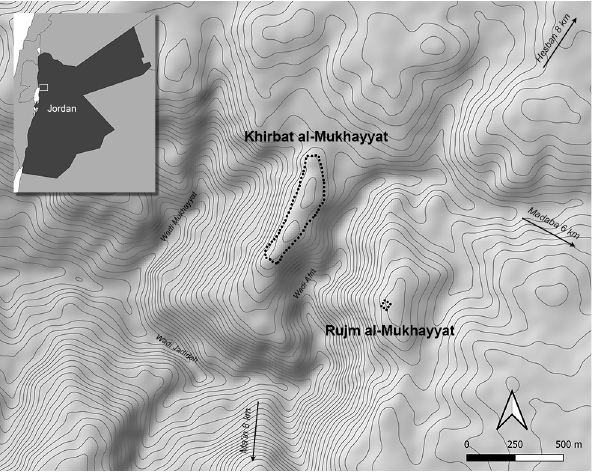
Figure 2: Map showing the locations of the fortified Iron Age town of Khirbat al-Mukhayyat and its adjacent watchtower at Rujm al-Mukhayyat. The dotted areas show the extents of each site. The boundaries of the study region are indicated in the upper left